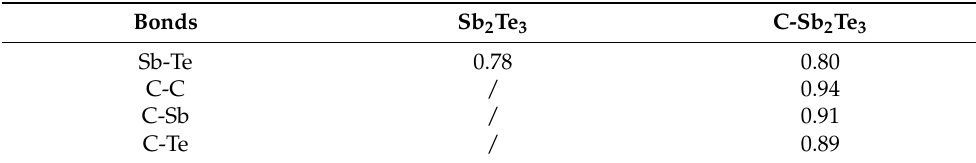
Figure 6. Two-dimensional electronic local function contour plots of Sb 2 Te 3 and C-Sb 2 Te 3 . ( a ) Σ 3 twin grain boundary FCC-Sb 2 Te 3 without doping C atoms and ( b ) Σ 3 twin grain boundary FCC- Sb 2 Te 3 -doped C atoms. Table 1. The maximum electronic local function value of each covalent bond in the FCC-Sb 2 Te 3 with Σ 3 twin grain boundary of undoped/doped C atoms in the direction of bond length.